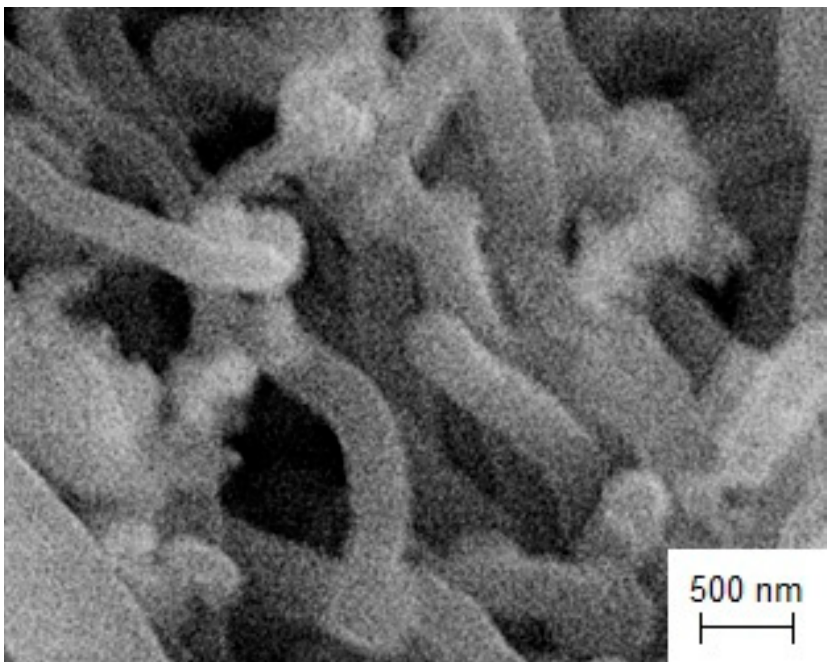
Figure 15. SEM image of the GdB 6 , synthesized in the KCl-NaCl-NaF (10 wt.%)-GdF 3 -KBF 4 melt at − 1.8 V vs. GC quasi-reference electrode.